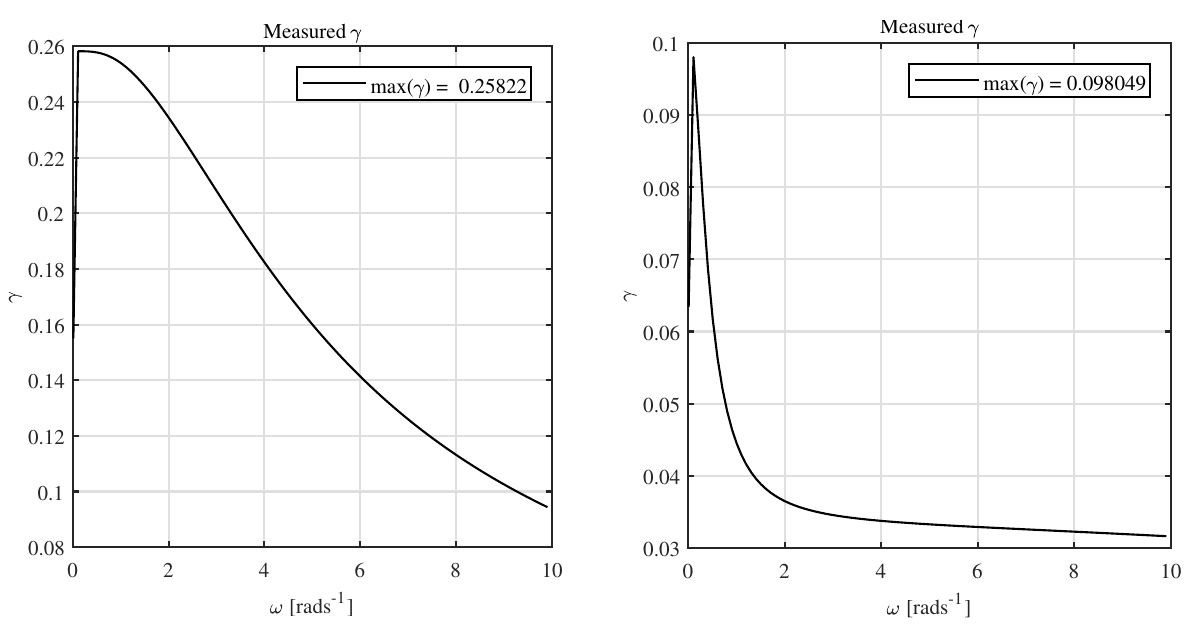
Figure 3: Measured γ according to ω .